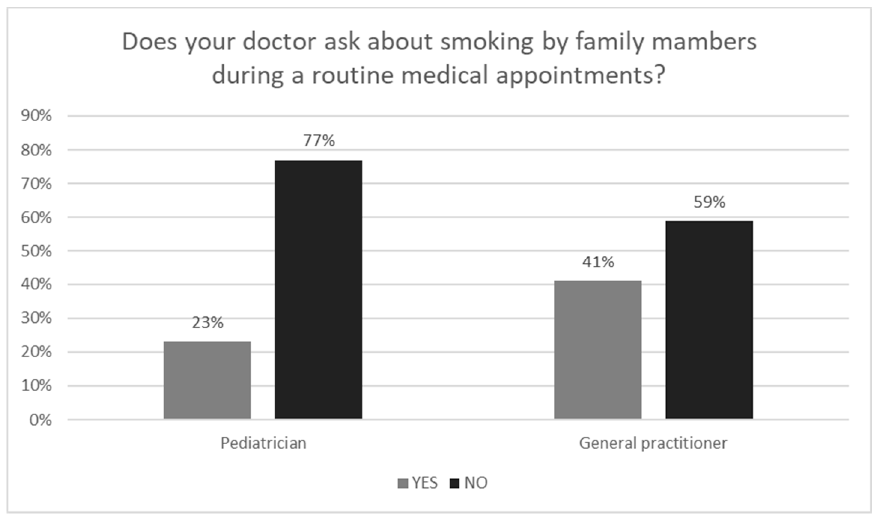
Figure 1. Screening and counseling for parental smoking in primary health care settings.